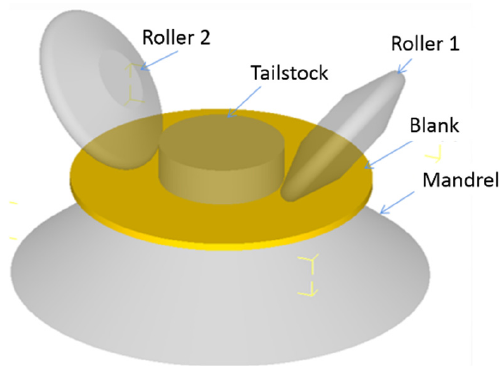
Figure 2. The finite element model of spinning.